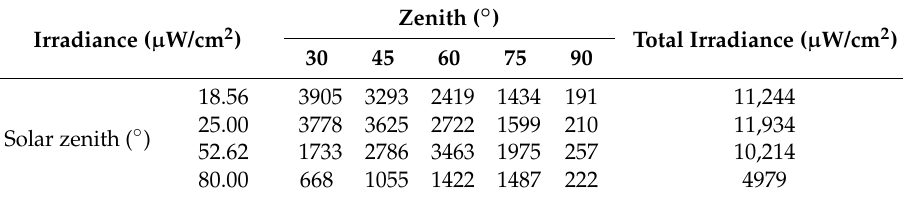
Table 7. Components of skylight irradiance from different zeniths on 22 June.